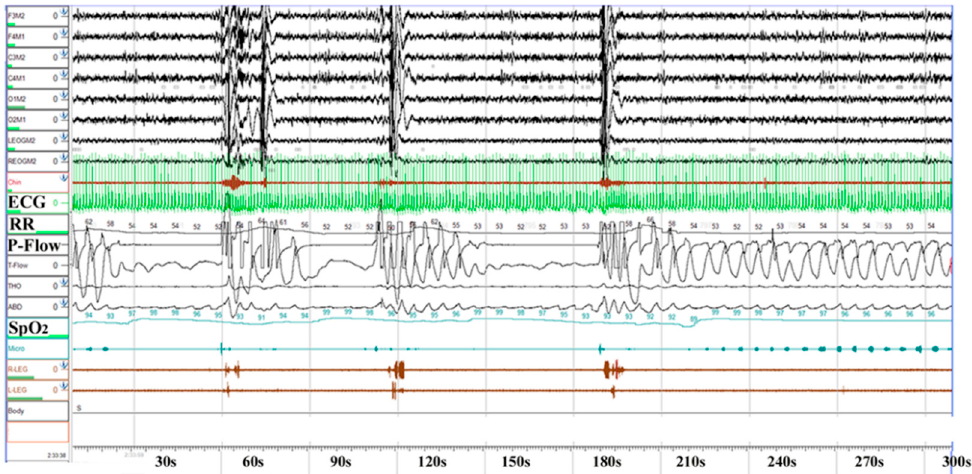
Figure 1. Polysomnography (PSG) findings in a patient with obstructive sleep apnea (OSA). The PSG findings obtained from a 60-year-old patient with severe OSA (apnea-hypopnea index 60) are shown. Note that SpO 2 repeatedly decreases and then increases with a cyclic variation of heart rate (CVHR). ECG, electrocardiogram; RR, R-R interval.